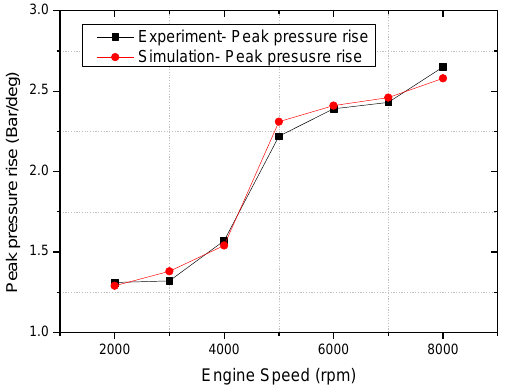
Figure 6. Peak temperature following engine speed.